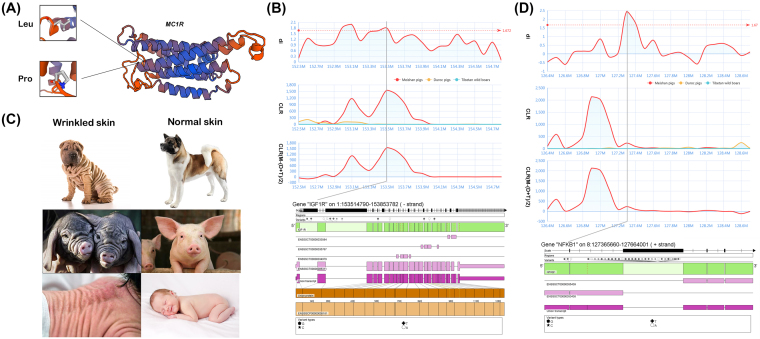
Specific genes with strong selective sweep signals in Meishan pigs. A) Prediction of protein conformation space for MC1R. Structure of Amino acids coded by exon 8 of porcine MC1R, as predicted by SWISS-MODEL. B) Candidate gene IGF1R for prolificacy in Meishan. Di values, CLR values, and ΔCLR values are plotted surrounding IGF1R gene. The bottom part showing the gene structure and all high ΔAF SNVs within a gene. The gray bar indicates the position of the IGF1R gene. C) Comparison of phenotype between the wrinkled and unwrinkled skin. D) Candidate gene NFKB1 for wrinkled skin and face of Meishan pig and the labelling is same to Fig. 6B.